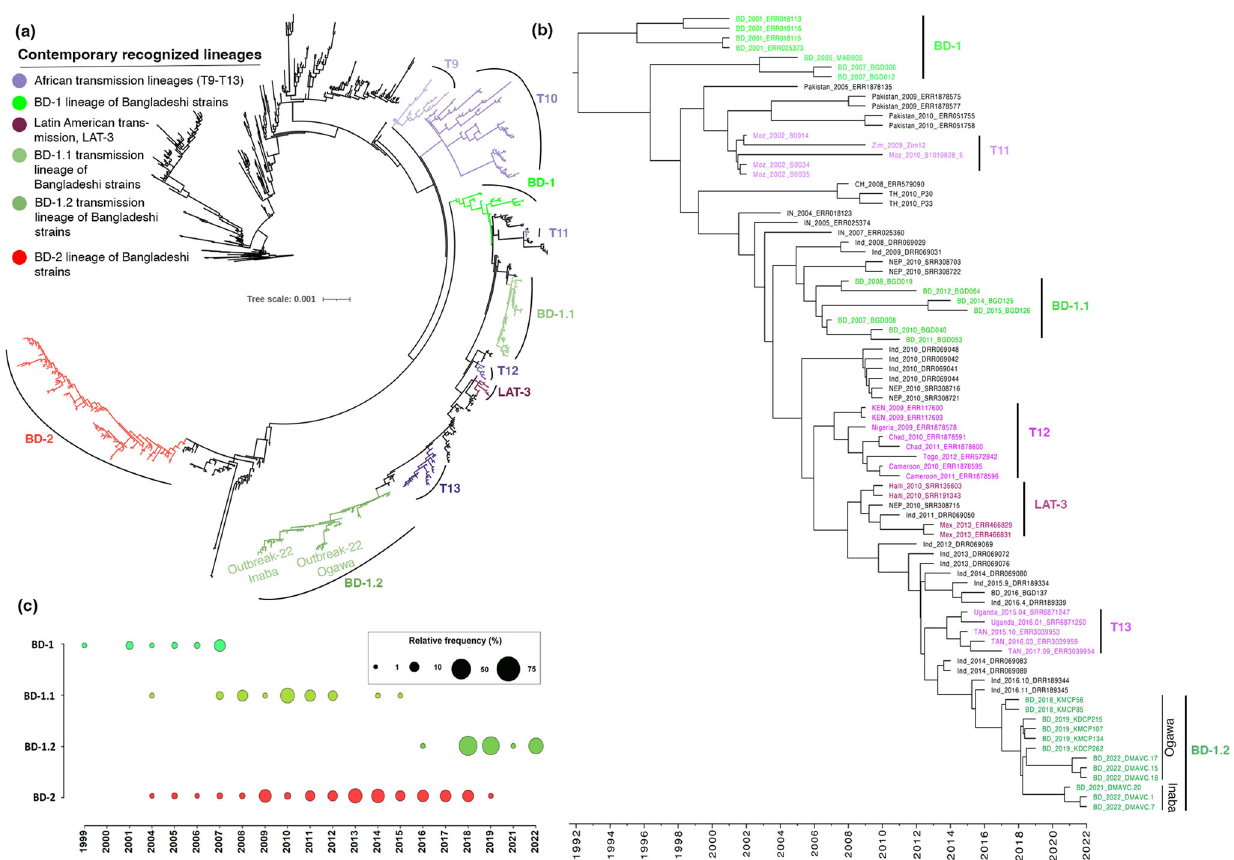
Fig. 2 | Phylogenetic relatedness of V. cholerae O1 El Tor stains isolated during the 2022 cholera outbreak in Dhaka, Bangladesh. a Maximum likelihood phy- logenetictreebasedon981genomesequences.Outgroupisrepresentedbyastrain isolated from Indonesia in 1957. Recently recognized and newly identi fi ed lineages ofstrainswereannotatedinthetree.Cladesofisolatesarecoloredaccordingtothe colorscheme attheleft.LineagesBD-1,BD-1.1, BD-1.2arede fi ned using colorgreen of differing intensity. BD-2 is de fi ned by the red color of the tree branches. All transmission lineages in Africa are colored purple with differing intensity, Latin